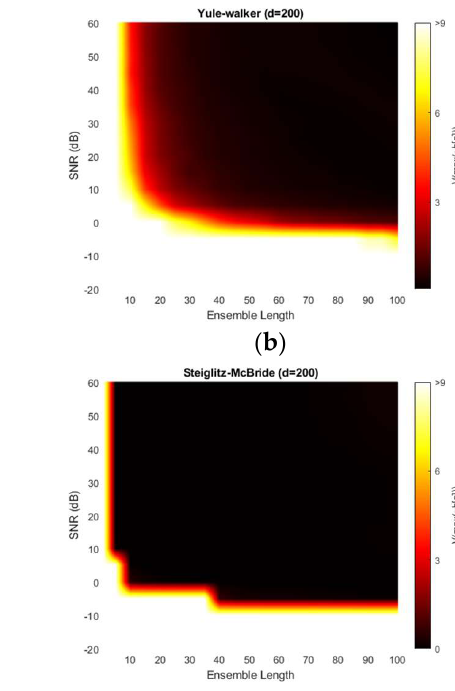
Figure 15. Average estimation error with given ensemble average length & SNR for 200-sample delay: